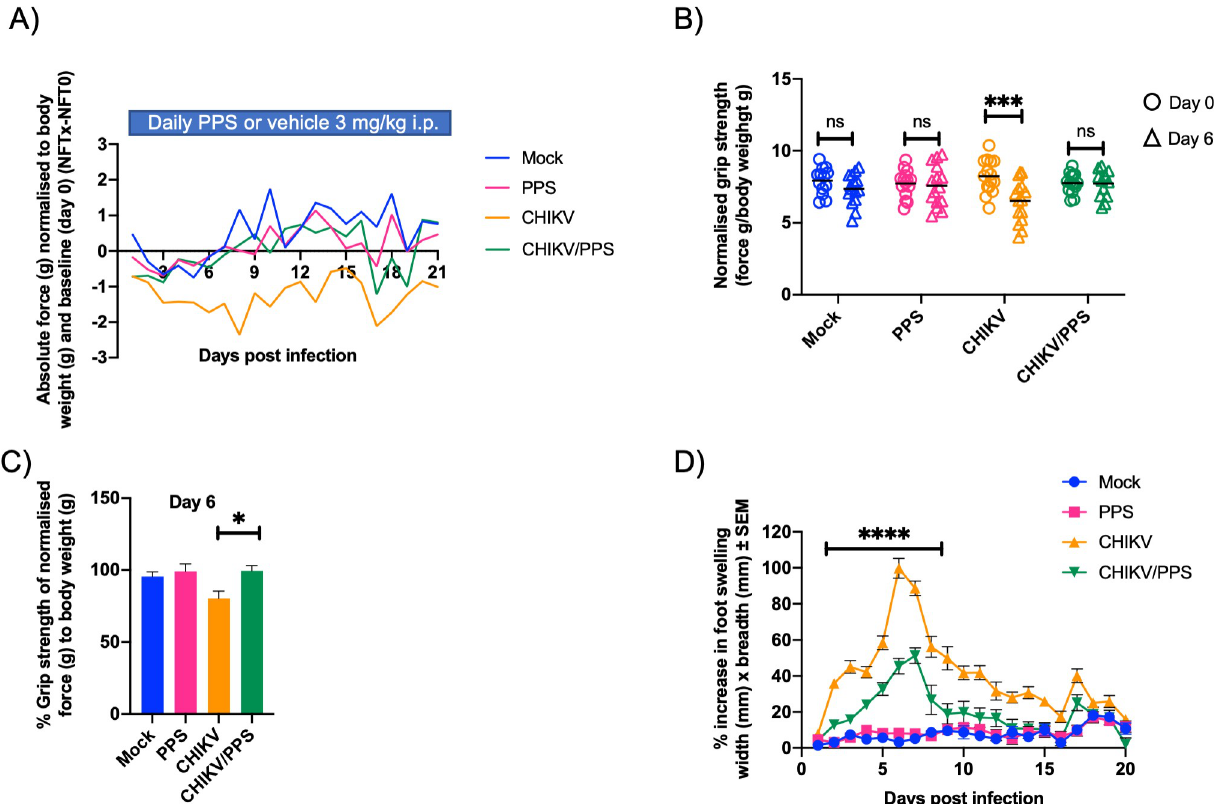
Fig 1. Treatment of CHIKV-infected mice with PPS improves grip strength and hind-foot swelling. C57BL/6 mice were infected s.c. with 10 4 PFU CHIKV or PBS alone and received daily injections of PPS or mock-treatment with PBS. Mice were measured daily (in triplicate) for grip strength and joint swelling (both hind feet). All data are presented as mean ± SEM, n = 15 mice from days 0–7 and n = 5 mice from days 8–21 post-infection. Mock- infected; mock, mock-infected PPS-treated; PPS, CHIKV-infected mock-treated; CHIKV, CHIKV-infected PPS-treated; CHIKV/PPS. (A) Grip strength described as absolute force (g) normalised to body weight (g) and compared to baseline (day 0) (NFTx—NFT0). Significant differences ( ���� P < 0.0001) were observed between CHIKV-infected untreated mice and all other groups, CHIKV-infected untreated; vs mock, vs PPS alone, and vs CHIKV-infected PPS-treated. One-Way ANOVA , Tukey’s post-test (B) Normalised grip strength described as force (g)/body weight (g) at days 0 and 6 post-infection. Grip strength was significantly reduced between baseline (day 0; 8.2 ± 0.3) and peak disease (day 6; 6.5 ± 0.4) in the CHIKV-infected untreated group only ( ��� P < 0.0002). All other groups displayed no significant differences in grip strength between days 0 and 6 post-infection, Two-Way ANOVA and Sidak’s multiple comparisons test . (C) Percentage change in normalised grip strength [force (g)/body weight (g)] between 0 and day 6 post-infection. At 6 d.p.i., CHIKV-infected untreated mice lost 19.8% ± 5.1 of their original strength compared to a 0.5% ± 3.6 reduction for the CHIKV-infected PPS-treated mice. There were no statistically significant changes observed between mock, PPS alone and CHIKV-infected PPS-treated groups. One-Way ANOVA with a Tukey’s post-test . (D) CHIKV-induced joint swelling measured daily in triplicate and displayed as percentage increase compared to baseline. Significant reductions in swelling were observed between the CHIKV-infected untreated and CHIKV-infected PPS-treated mice between 2 and 11 d.p.i. and 13 and 14 d.p.i. P values were: 2 d.p.i. to 9 d.p.i. ( ���� P < 0.0001), 10 d.p.i. ( �� P = 0.0039); 11 d.p.i. ( ��� P = 0.0007); 13 d.p.i. ( � P = 0.0399), and 14 d.p. i. ( � P = 0.0108). Two-Way ANOVA with a Tukey’s post-test